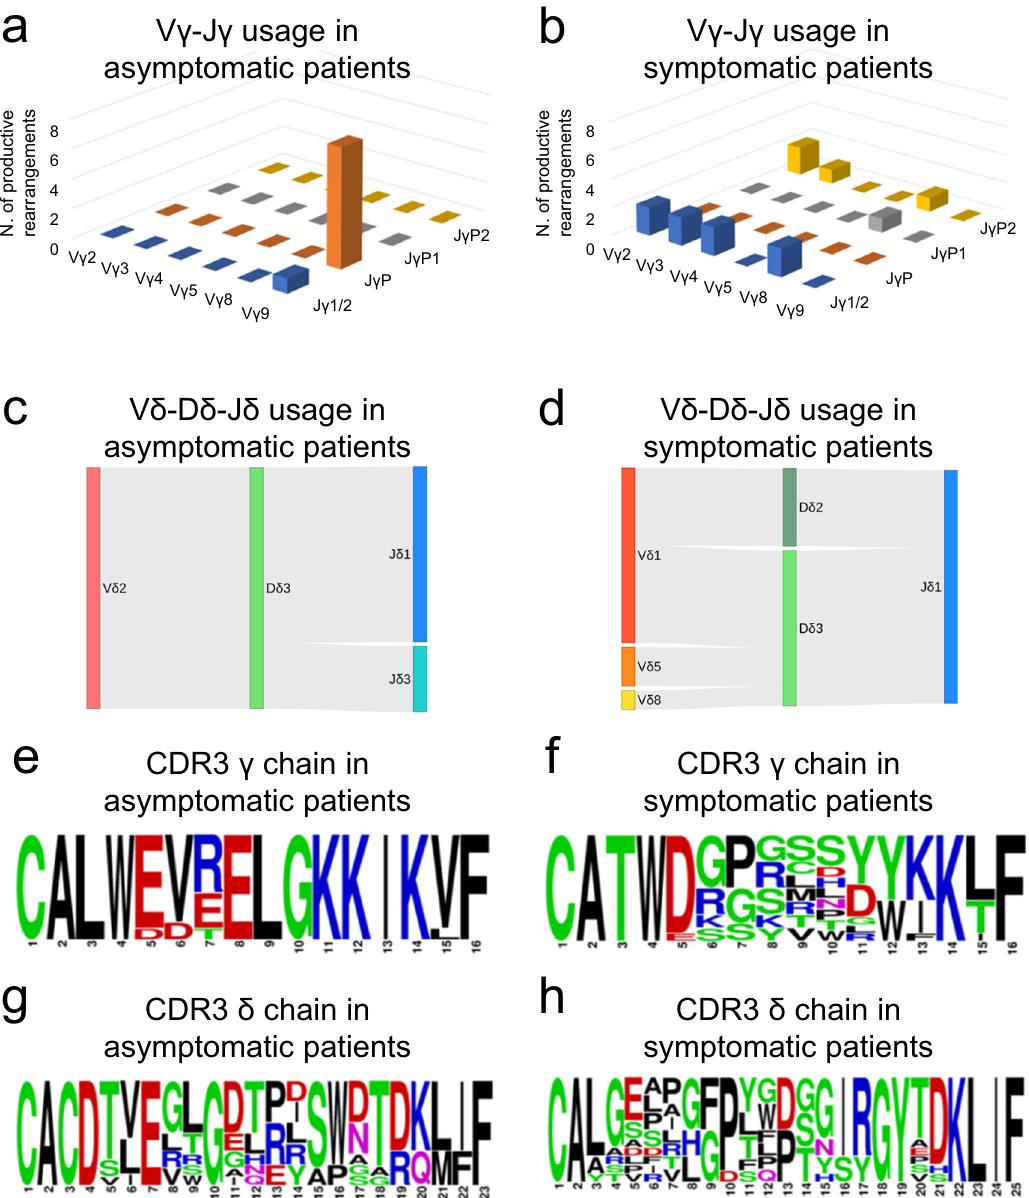
Fig. 1 V(D)J rearrangement of gamma and delta chain in asymptomatic ( n = 5) and symptomatic ( n = 6) patients affected by T γδ neoplasm. a , b Combinatorial usage of VJ γ genes (reported in the x and z axis) shown as histogram of the major productive gamma rearrangements reported in Table 1. c , d Combinatorial usage of VDJ δ genes shown as Sankey plot (vertical bars indicate segments, the connecting stripes the frequency of pairwise combinations) of the major productive delta rearrangements reported in Table 1. V γ 9-J γ P ( n = 8) and V δ 2-D δ 3-J δ 1 ( n = 8) are the productive combinations most frequently detected among major clones of asymptomatic patients ( a and c ), whereas they are absent in symptomatic cases ( b and d ). e , h Gamma and delta CDR3 amino acid composition observed in the asymptomatic ( e and g ) and symptomatic group ( f and h ) is visualized using WebLogo online tool after sequence alignment performed by ClustalW. Amino acids are colored according to their chemical properties: polar amino acids are shown as green, basic blue, acidic red, and hydrophobic amino acids as